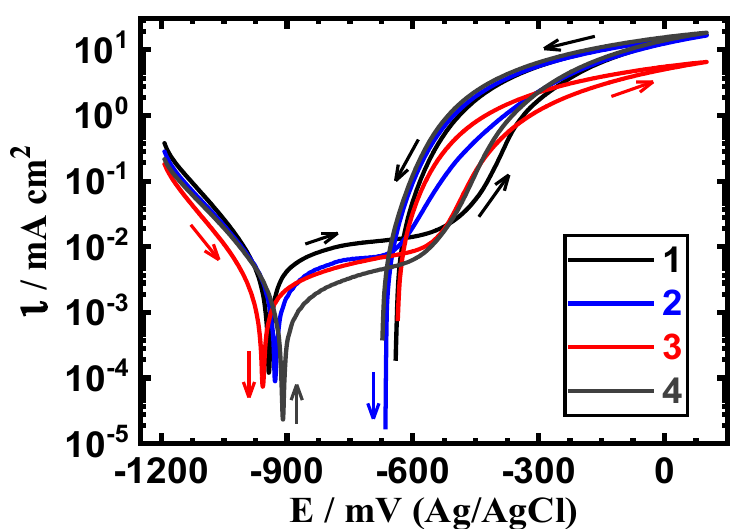
Figure 6. CPP curves for iron after 1 h immersion in (1) 3.5% NaCl solutions in the absence and